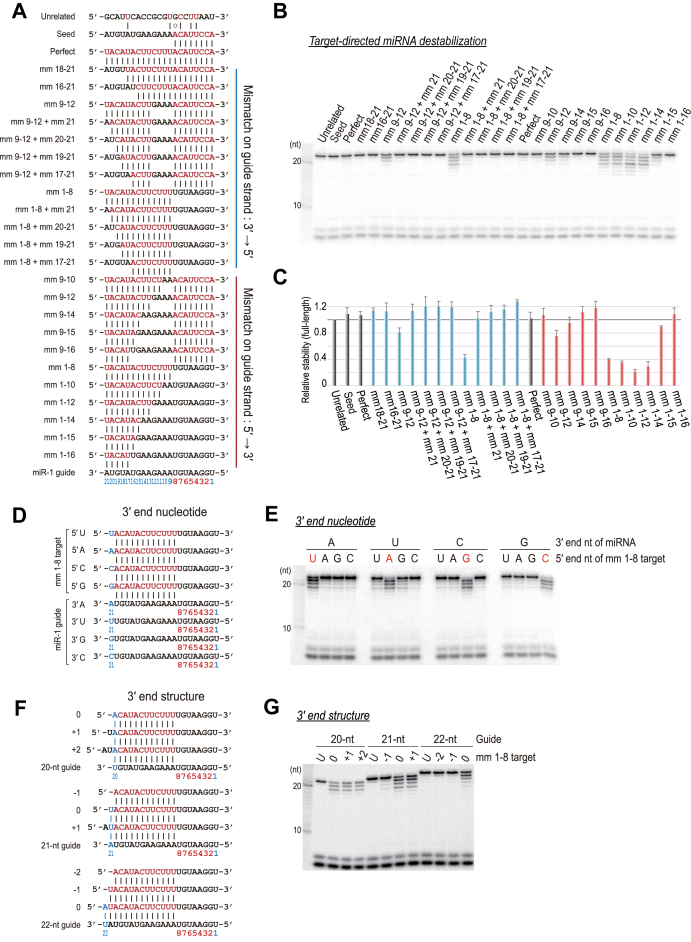
3΄ complementarity confers specificity for target-directed destabilization. (A) Schematic of paired miRNA and complement target RNAs. (B) 3΄ complementarity confers a specificity of destabilization. (C) Quantitation of (B). The mean ± SD for at least two independent experiments is shown. (D and E) A single mismatch at the 3΄ end nucleotide largely abrogates the destabilization, regardless of the identity of the 3΄ end nucleotide of the guides or (F and G) the 3΄ end structure of guide–target duplexes.